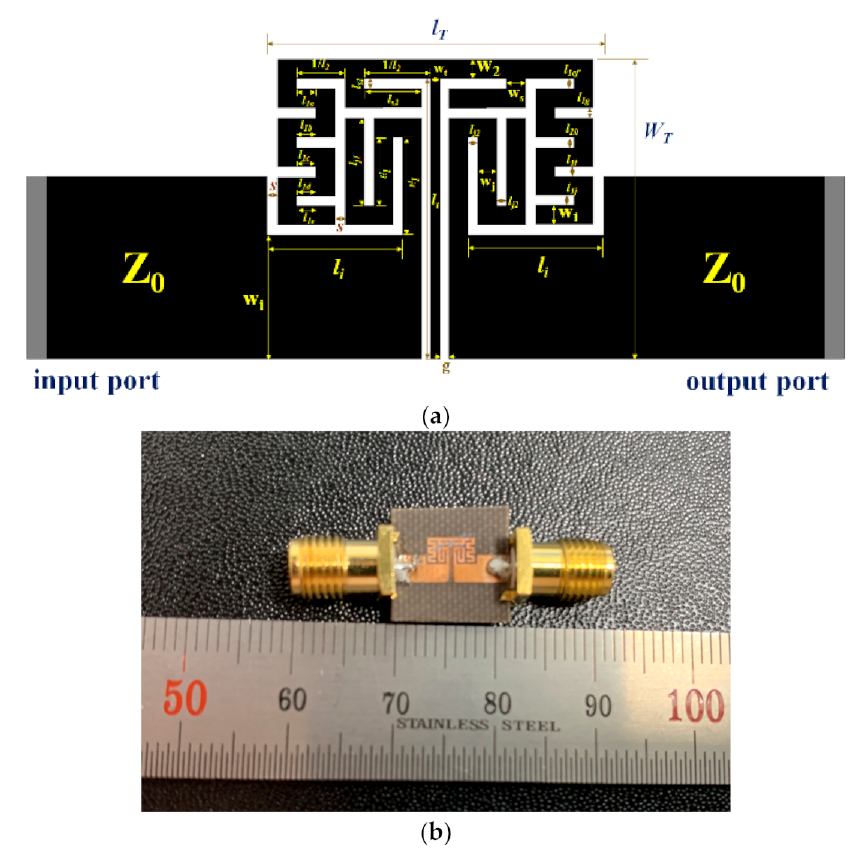
Figure 4. ( a ) Design layout and ( b ) fabricated